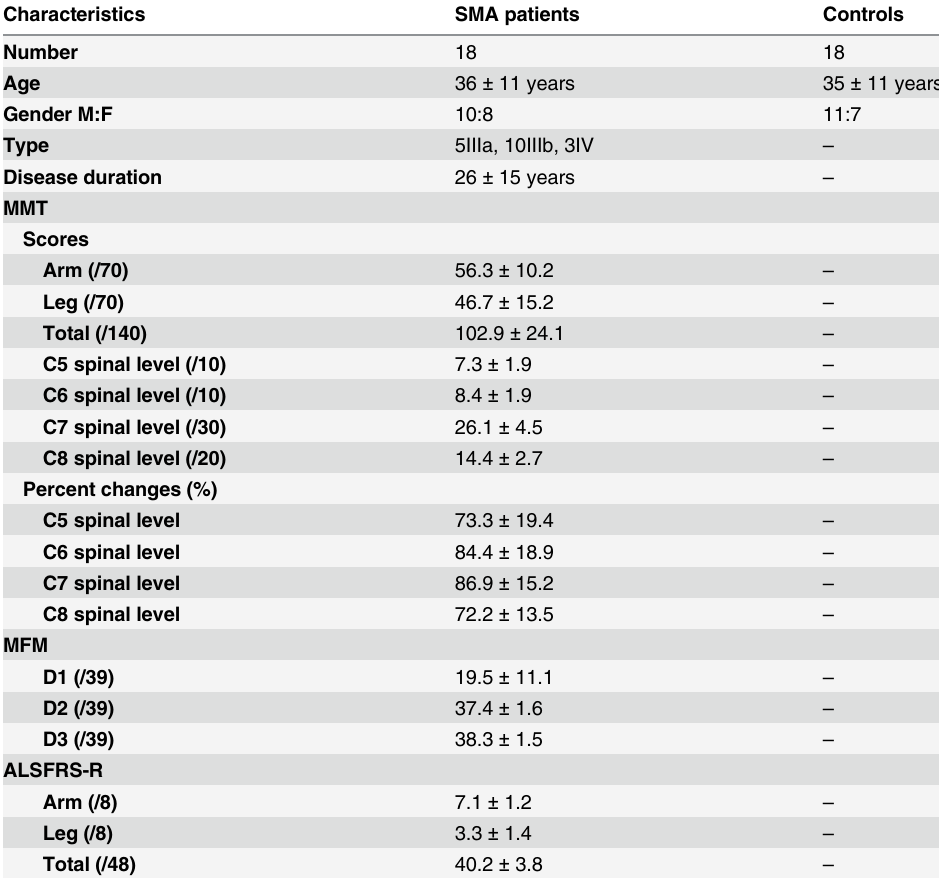
Table 1. Population demographics and clinical features in SMA patients.